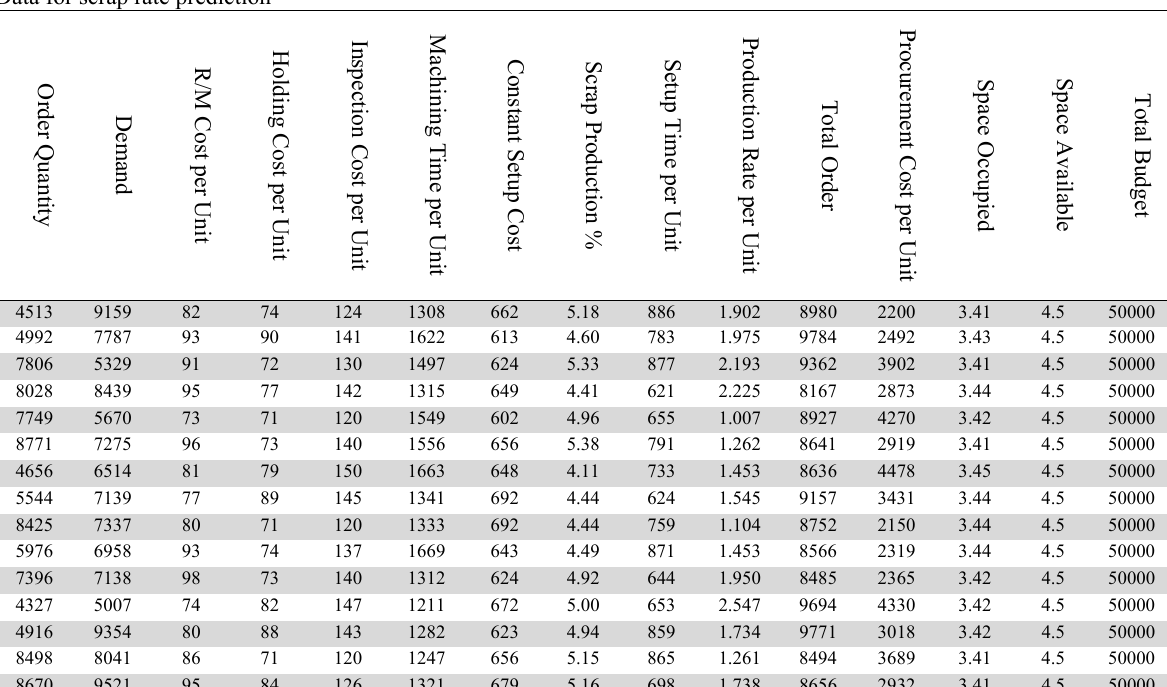
Table C2 Data for scrap rate